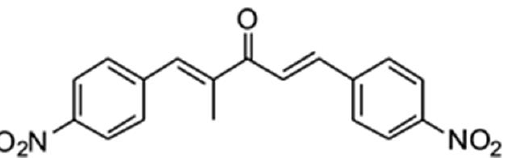
Figure 1. Chemical structure of (1E, 4E)-2-methyl-1,5-bis(4-nitrophenyl) penta-1,4-dien-3-one ( A3K2A3